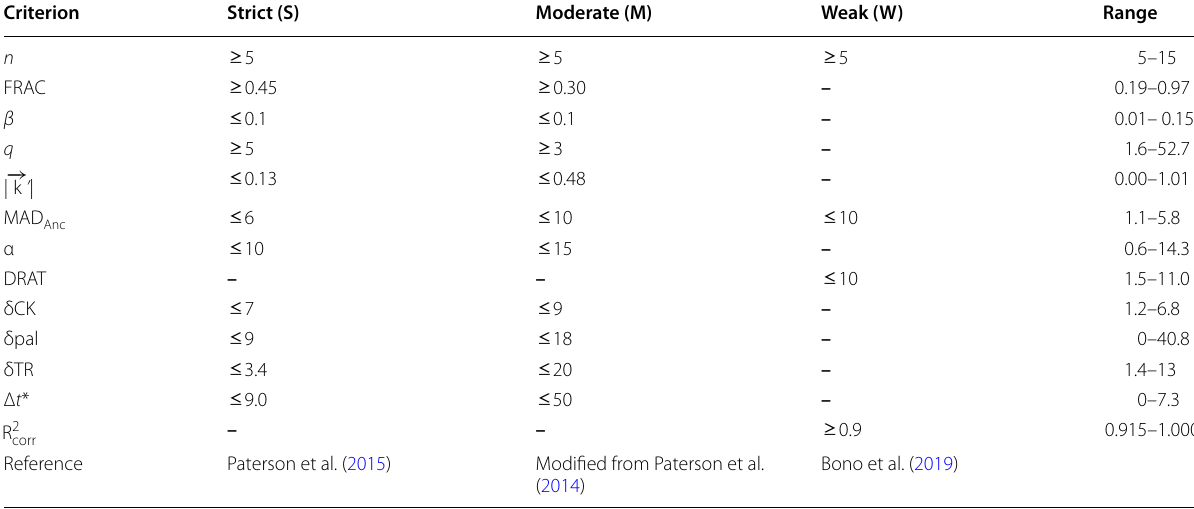
Table 2 Criteria sets were used for classification of the paleointensity results